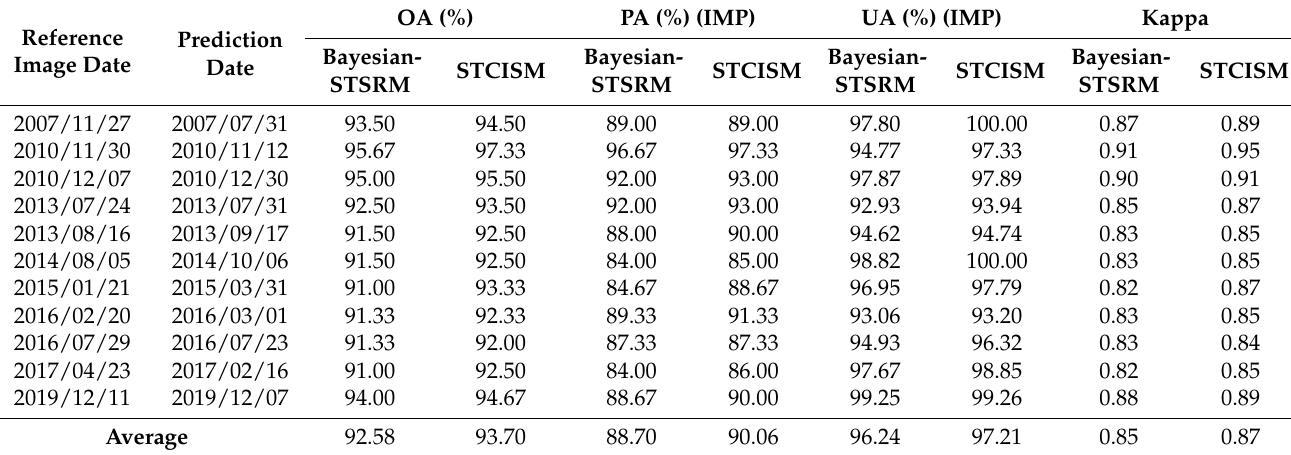
Table 1. Accuracy of the Bayesian-STSRM and STCISM.